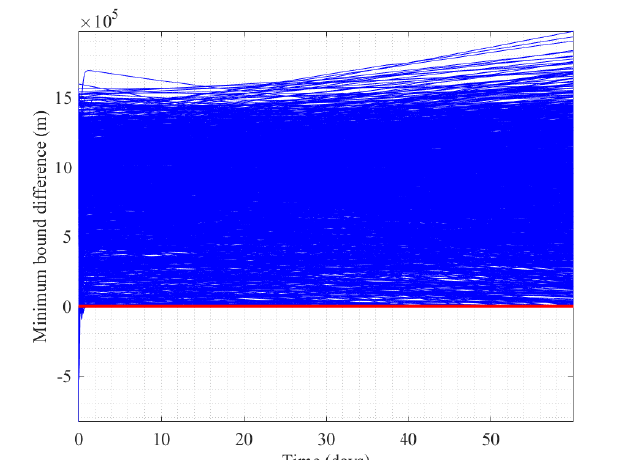
Figure 23. Maximum bound differences of constellation satellites. Red line is zero-value standard. Blue lines are maximum bound differences.